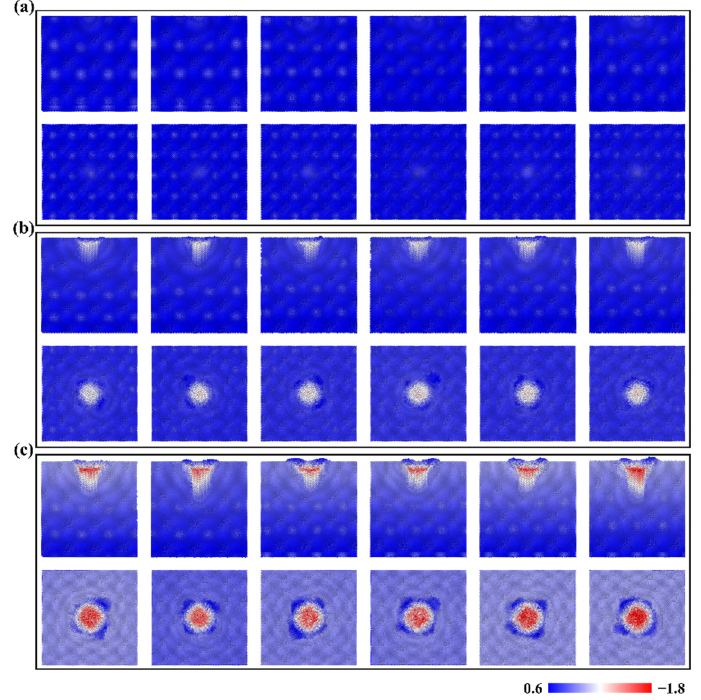
Figure 3. Snapshots of displacements in the y-direction of various Zr content (0–5 wt.% from left to right) under different depths ( a – c ); ( a ) 0.5 nm, ( b ) 1.5 nm and ( c ) 2.0 nm. The top diagram shows the cross-section snapshot in the [100] direction, and the bottom diagram shows the top view snapshot. Snapshots of the instantaneous microstructure defects at different indentation depths